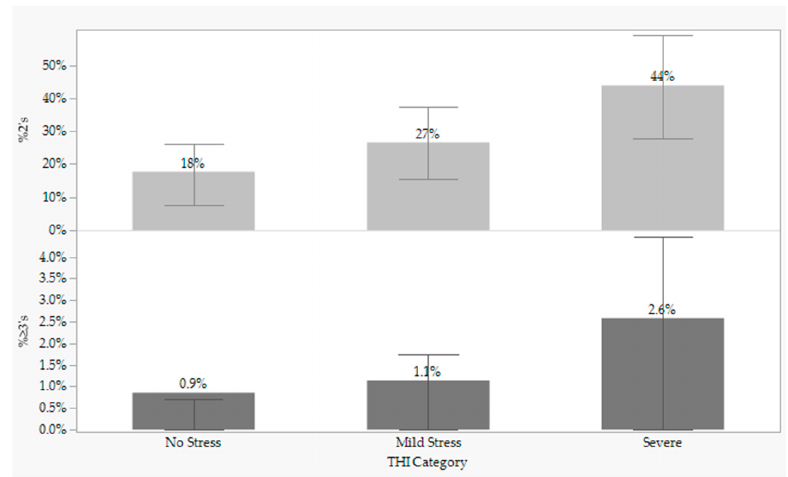
Figure 1. Prevalence of mobility scores utilizing the NAMI mobility scoring system [19] by temperature humidity index (THI) stress categories ( N = 158 lots representing 15,388 head of cattle). Mobility scores were defined as: 1 = normal, walks easily, no apparent lameness, no change in gait; 2 = exhibits minor stiffness, shortness of stride, slight limp, keeps up with normal cattle; 3 = exhibits obvious stiffness, difficulty taking steps, obvious limp, obvious discomfort, lags behind normal cattle; and 4 = extremely reluctant to move even when encouraged by a handler; statue-like. THI stress categories were defined as follows: No Stress = THI < 72; Mild Stress = 72 ≤ THI < 79; Severe Stress = 79 ≤ THI < 89; Very Severe Stress = 89 ≤ THI < 98; and Dead Cows = > 99 [20]. There were no lots within the Very Severe Stress and Dead Cows categories. Error bars represent the interquartile range for each category. Table 6. The modeled relative risks associated with significant regression model components im- pacting the prevalence of non-normal mobility scores 1 .